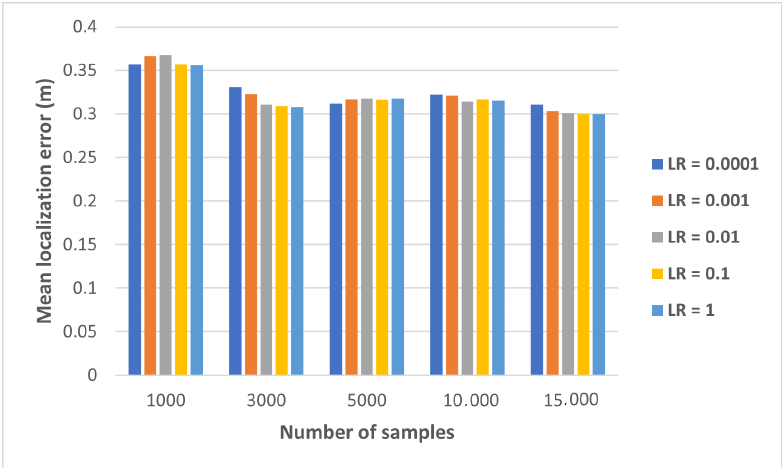
Figure 7. Mean localization error for the used